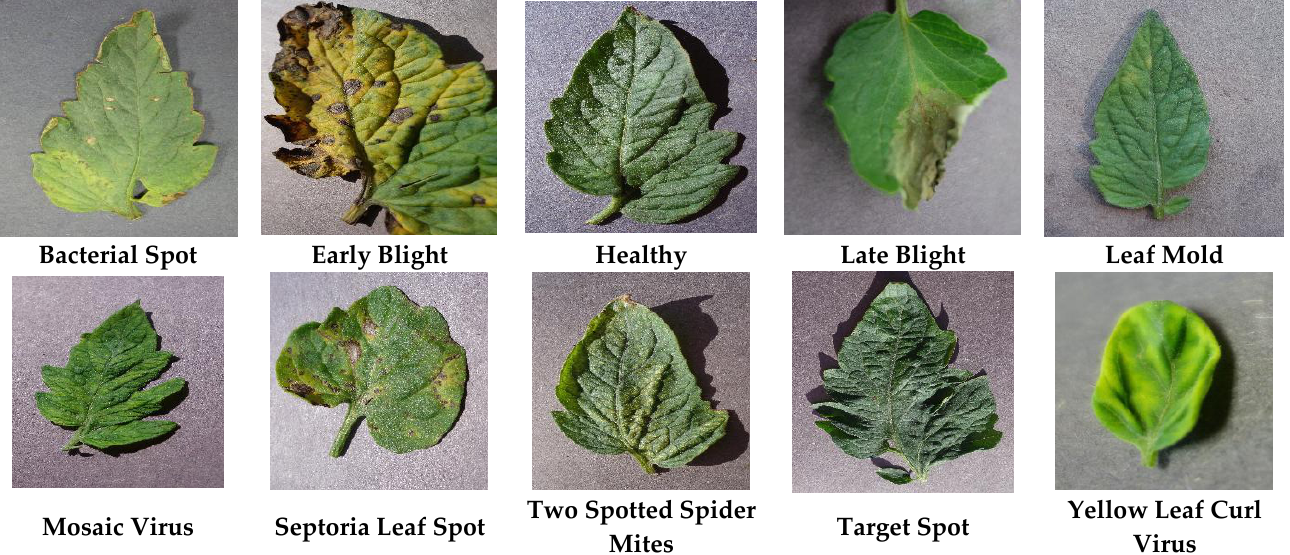
Figure 1. Instances of tomato leaf pictures of the PlantVillage dataset. Table 1. The distribution of pictures among each class label of the PlantVillage